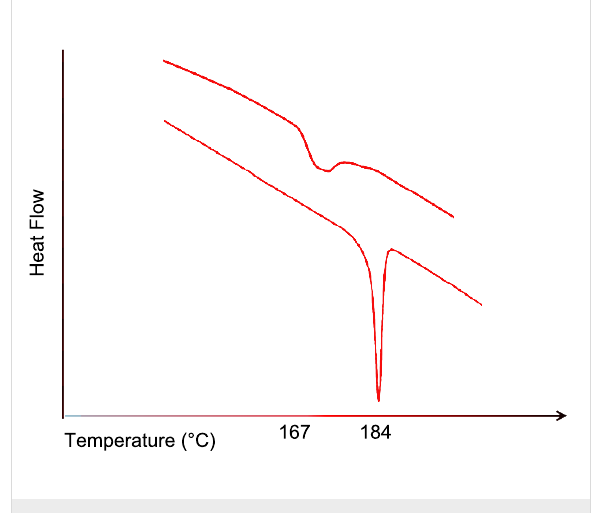
Figure 3: DSC cooling scans of as-received (upper) and coalesced N-6 (lower)